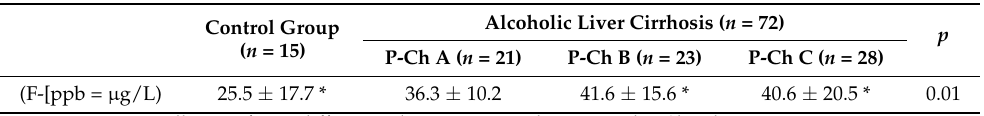
Table 3. Serum fluoride concentrations in Patients with Alcoholic Liver Cirrhosis Compared to the Control